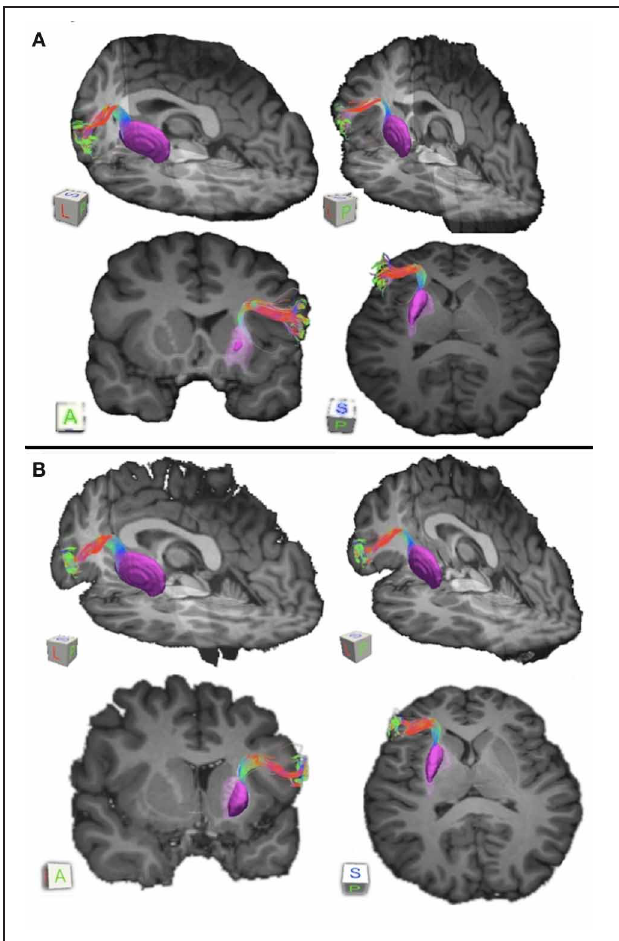
FIGURE 1 | Pathways connecting pars triangularis (A) and pars opercularis (B) and anterior putamen (purple) in a representative participant (participant 3). Color gradient of pathways represents directionality of fiber orientation: red left-right, green anterior-posterior, blue superior-inferior. The cubes located to the right each image represent spatial orientation of the brain. Letters on the faces of the cubes represent directions: A, anterior; P, posterior; S, superior; L, left. The images depict a single participant (participant 3).